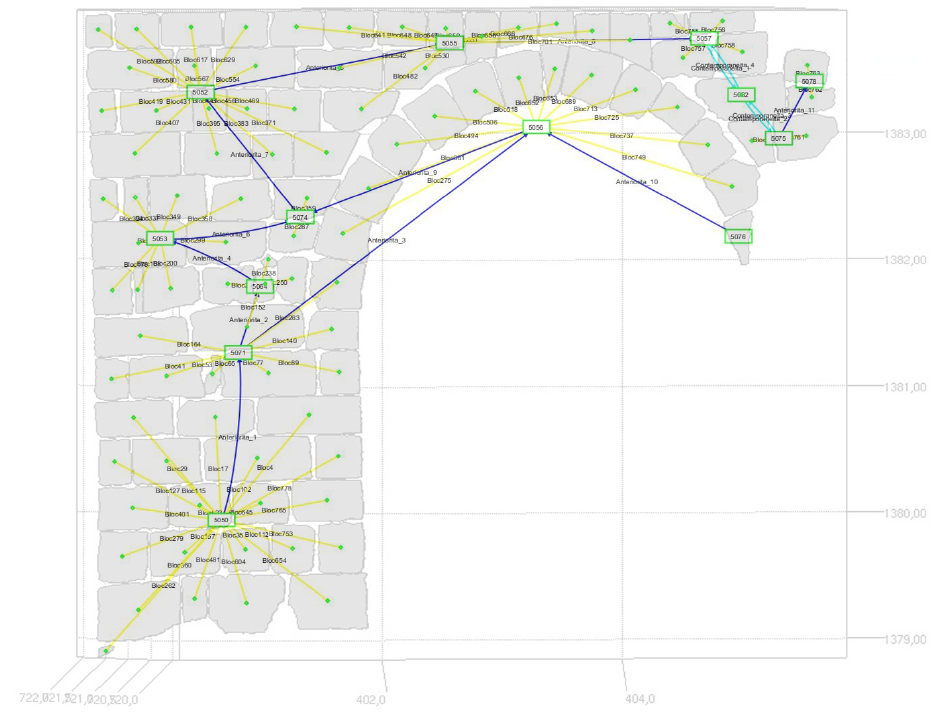
Figure 15. 2D bloc representation with the stratigraphic graph and bloc position. The nodes of the graphs are computed as centroids of US or block.